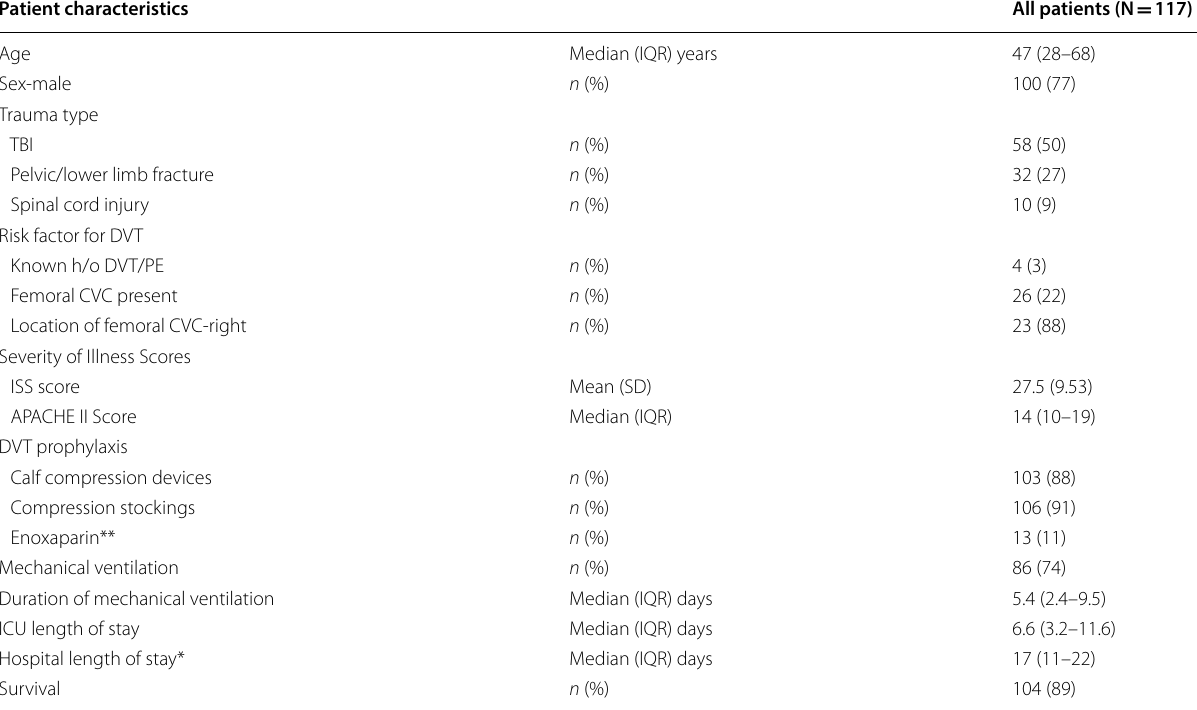
Table 1 Demographic and Clinical Characteristics of the patients in the study